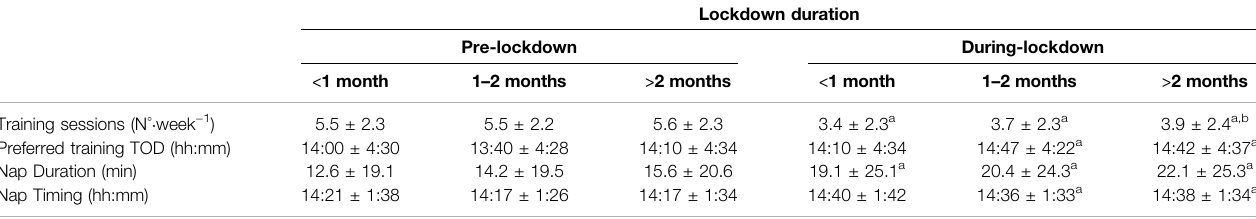
TABLE 3 | Training and napping behavior pre- and during-lockdown according to the lockdown duration.